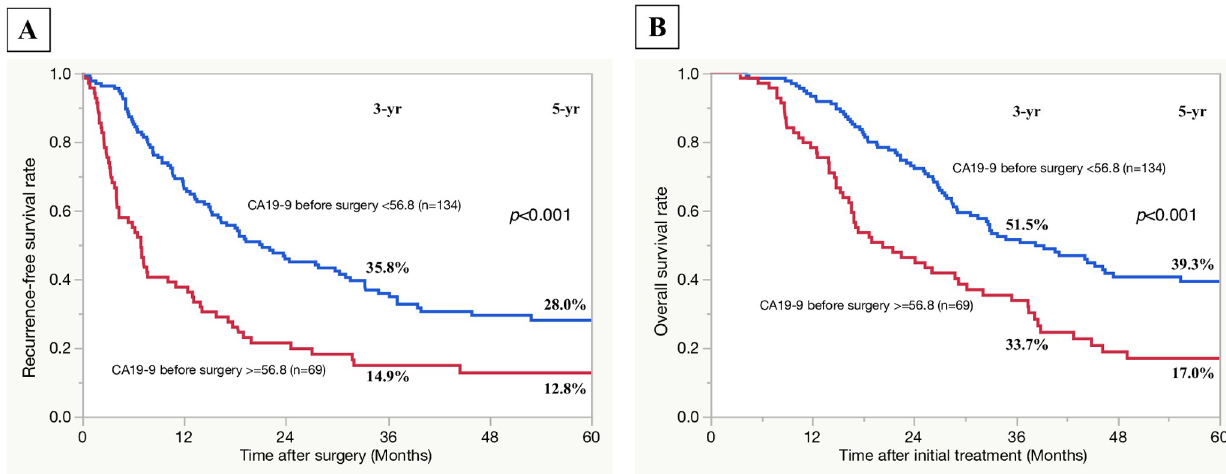
Fig 4. Comparison of recurrence-free and overall survival curves based on the serum level of CA19-9 level before surgery (CA19-9 before surgery = > 56.8 vs. < 56.8 U/ml). A: recurrence-free survival rates; B: overall survival rates after initial treatment.